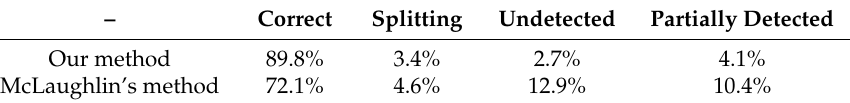
Figure 8. Power-line reconstruction results of splitting situation. Table 2. Reconstruction accuracy.